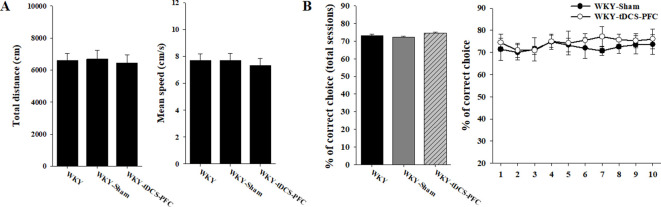
Effects of HD-tDCS application on cognitive behaviors in WKY rats, the genetic control model of ADHD.(A) Open-field test, total distance, and mean speed traveled (n = 5). (B) DNMTP T-maze, total % of correct choices for 10 sessions, and comparisons of % correct choices to the WKY-sham and the WKY-tDCS-PFC groups (n = 5). Data are presented as mean ± SEM.